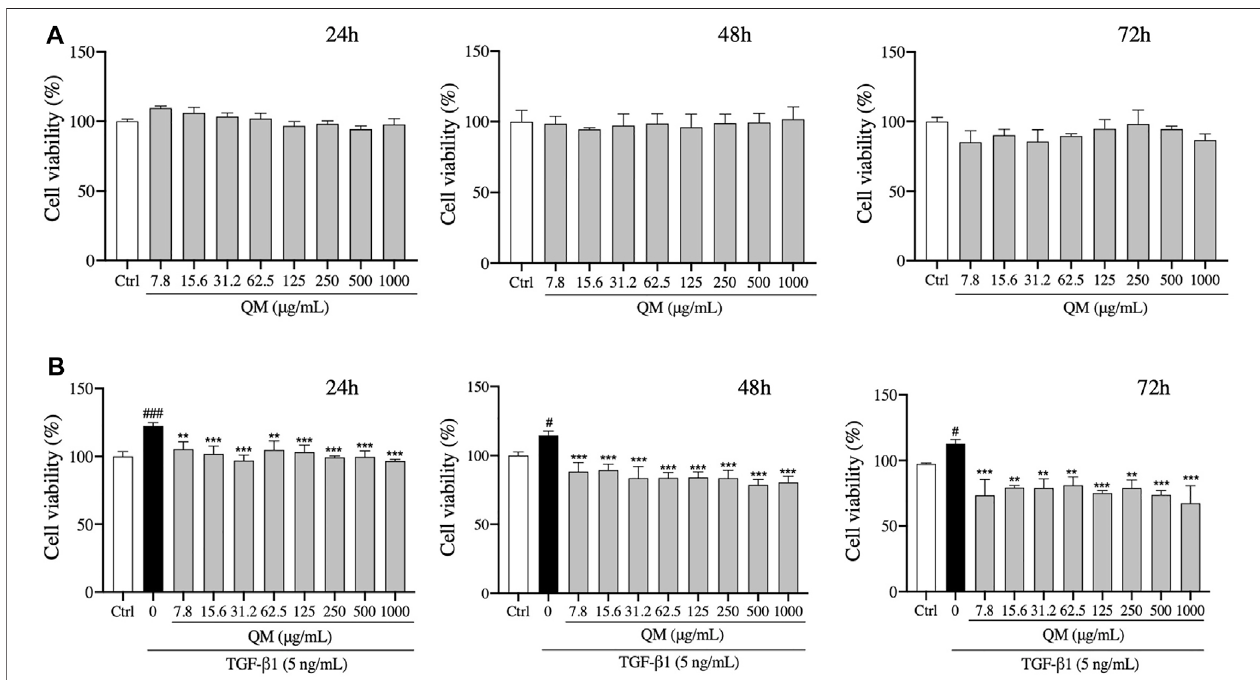
FIGURE 4 | QM inhibited the proliferation of TGF- β 1 – stimulated A549 cells. (A) After treatment with different doses of QM for 24, 48, and 72 h, the cytotoxicity of QM in A549 cells was evaluated by the MTT assay. (B) In TGF- β 1 – induced A549 cells, the effect of different doses of QM on cell viability after treatment for 24, 48, and 72 h was evaluated by the MTT assay. Data are shown as mean ± standard deviation from three independent experiments. # p < 0.05, ### p < 0.001 versus the control group; ** p < 0.01 and *** p < 0.001 versus the model group (TGF- β 1, 5